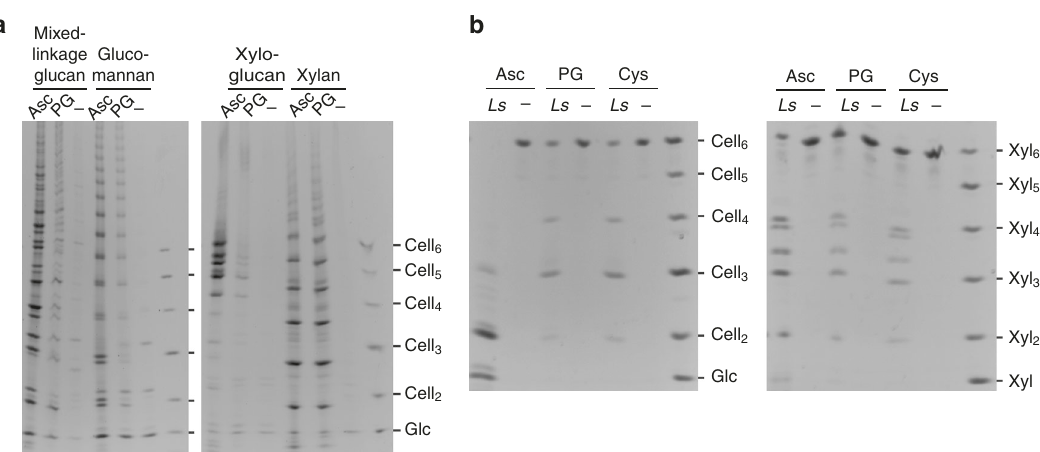
Fig. 4 Ls AA9A activity on different poly- and oligosaccharide substrates show differing sensitivity to reducing agent potential. a PACE gels showing products of Ls AA9A activity on MLG, glucomannan, xyloglucan and xylan polysaccharides using 4 mM ascorbate or 4 mM pyrogallol as reductants (performed in triplicate). The migration standards are cello-oligosaccharides. b PACE gels showing products of Ls AA9A activity on Cell 6 and Xyl